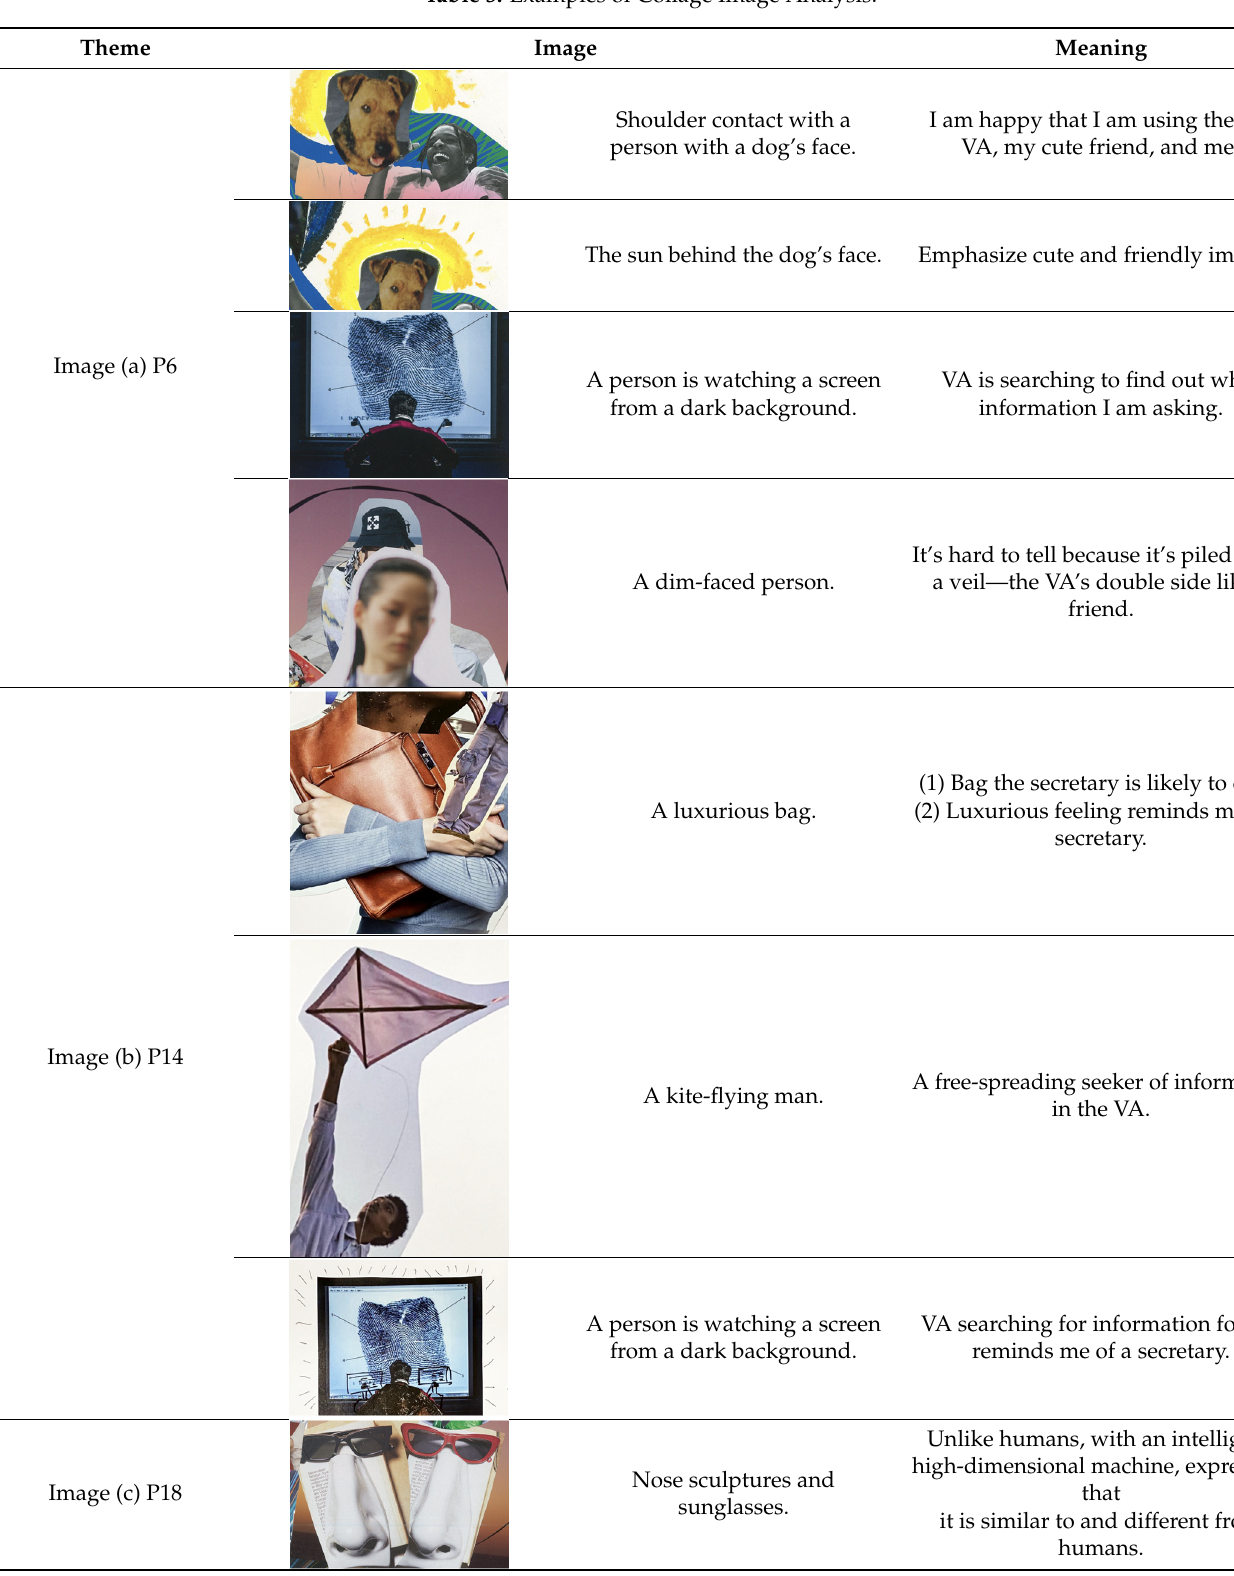
Figure 5. Collage Image of all participants. Table 3. Examples of Collage Image Analysis.